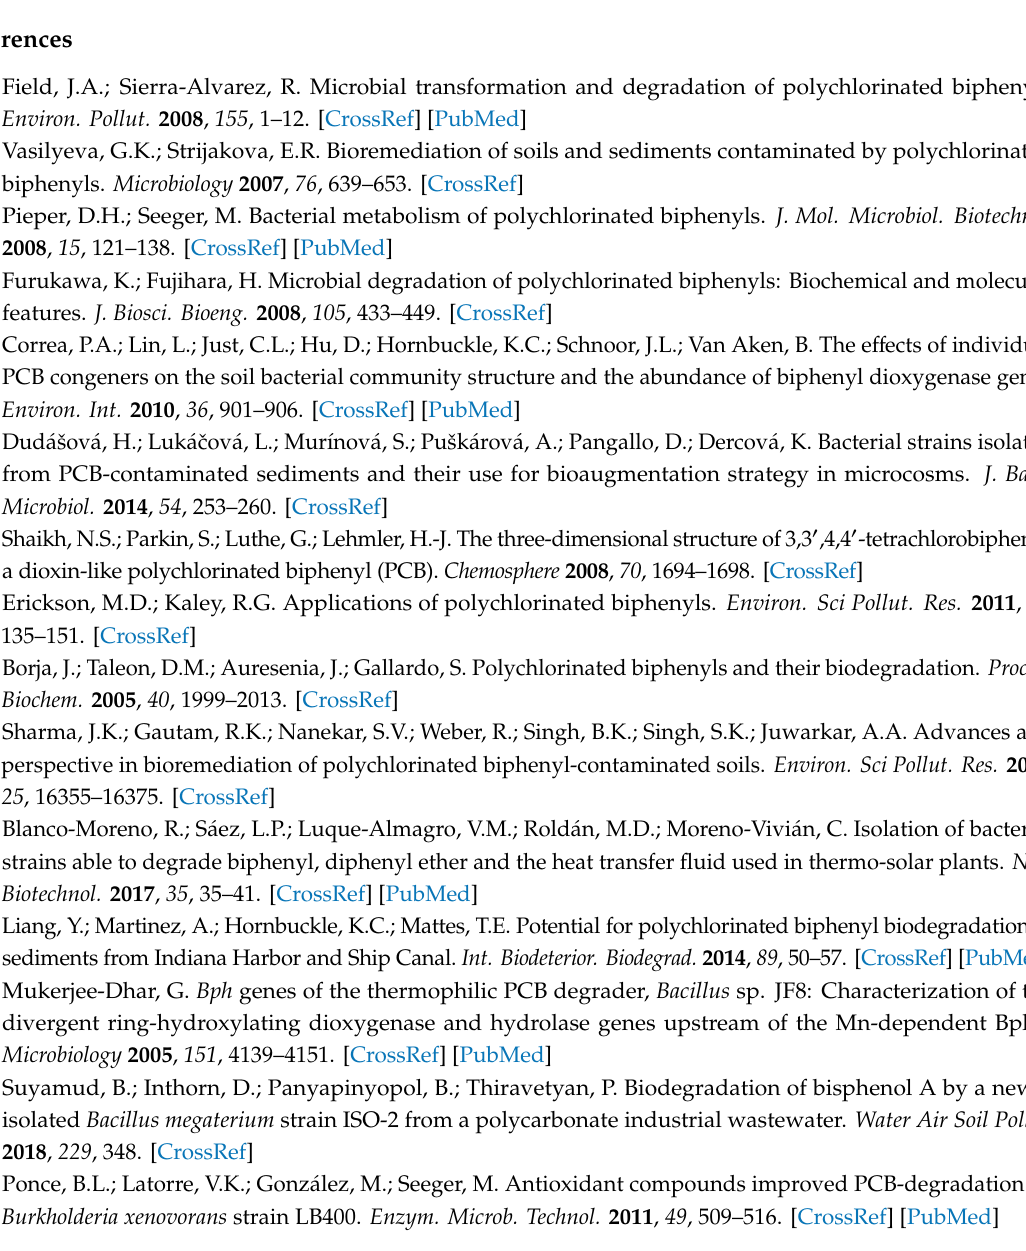
Table S2: Comparison of TPH, unidentified hydrocarons, alkanes ( Σ nC10–nC22, Σ nC23–nC40 content in sterile soil samples B and C after by Mycolicibacterium frederiksbergense IN53, Rhodococcus erythropolis IN129, Rhodococcus sp. IN306 and mixed culture M1 after the 30 days biodegradation process. Measurement repetition number n = 8–10, < 0.05, Table S3: Coe ffi cients of first-order mathematical model describing PCB and TPH pollutants Figure S2: Scheme of the test stand for conducting the process of biodegradation of pollutants (PCBs and TPH) in soil D under semi-technical conditions (ex situ prism method), Certificate of Analysis Soil A, Ecotoxicological analyses–description of the